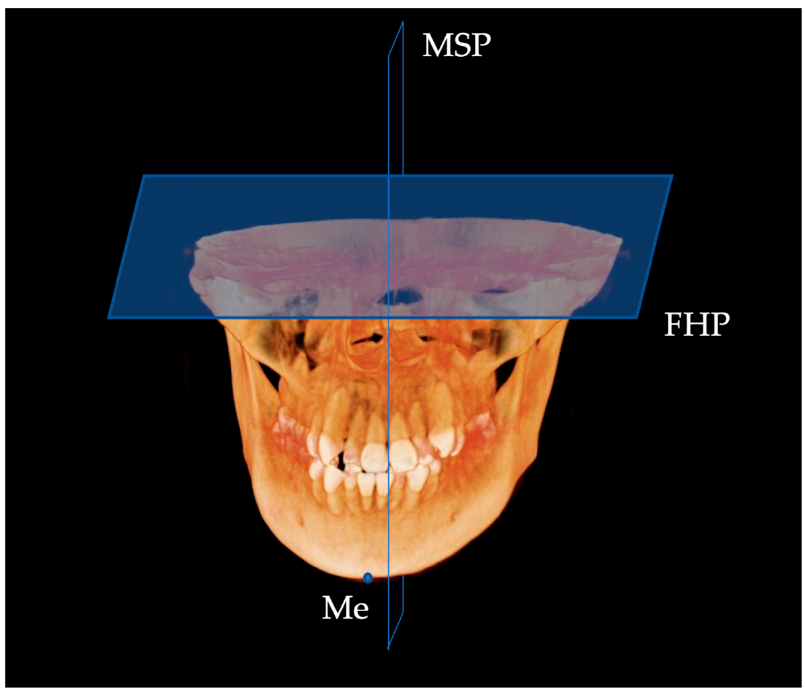
Figure 1. Facial midsagittal plane. MSP, midsaggital plane; Me, menton; FHP, Franfurt Horizontal Plane.